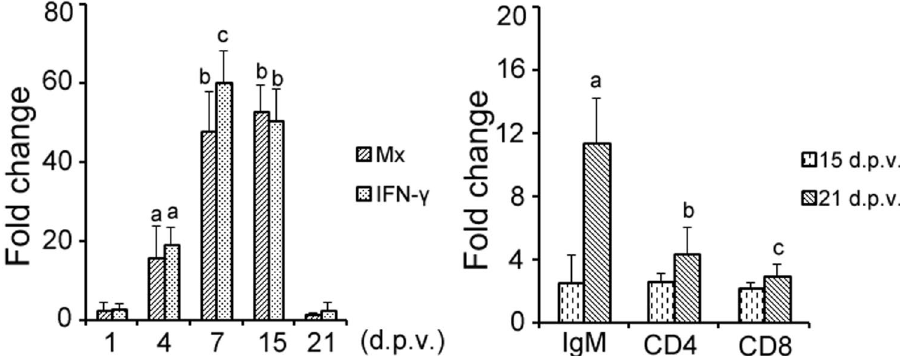
Figure 5. Fold changes in the expression of immune-related genes induced by the combined DNA vaccine in rainbow trout (n = 5). β -Actin was used to normalize the transcription of each gene in anterior kidney samples from rainbow trout at 1, 4, 7, 15, and 21 days post-vaccination (d.p.v.). The fold changes in their expression were calculated relative to their expression in the pcDNA3.1-vaccinated group. The differences were analysed, and different symbols above the bars indicate significant differences (P < 0.05).